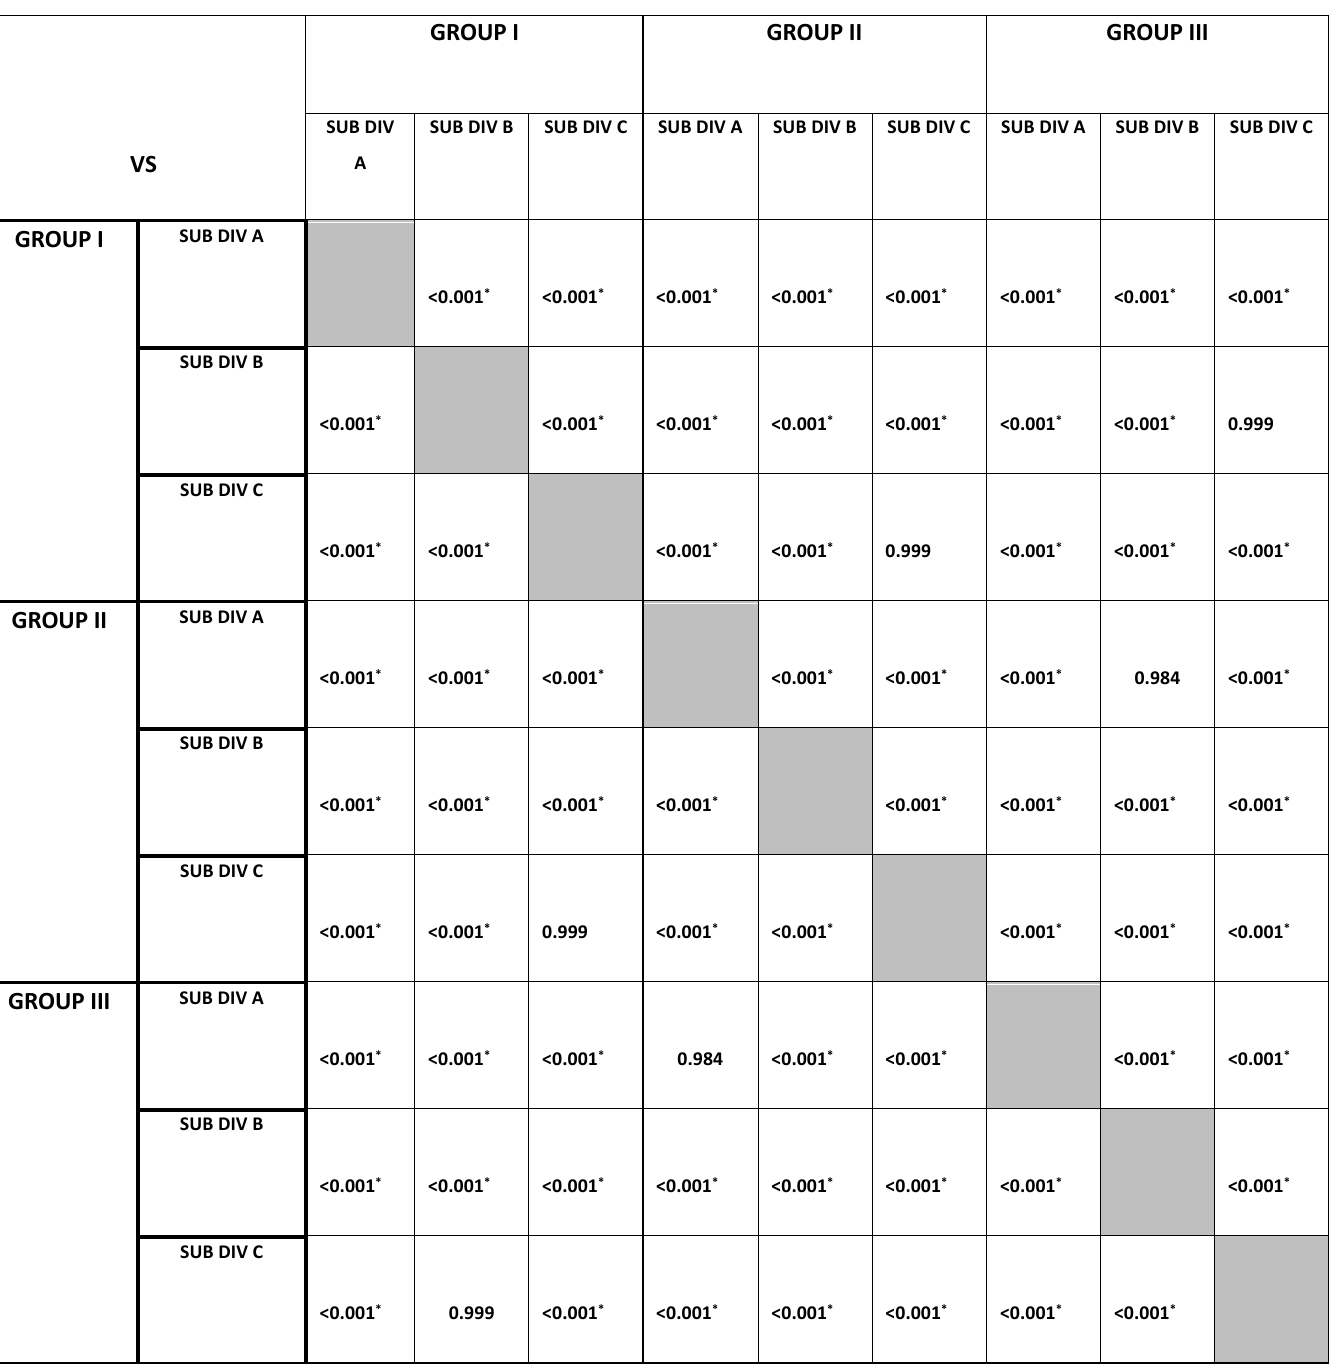
Table 6. A cross table showing interaction of subgroups with each other by post-hoc tukey test p value. (*Significant P